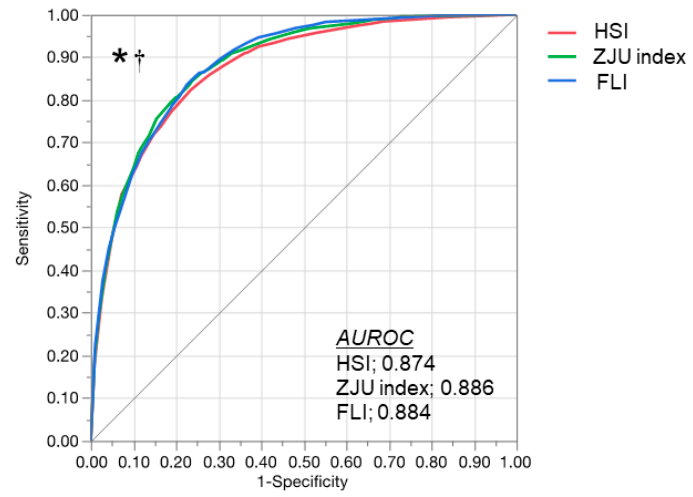
Figure 2. ROC curve of the HSI, ZJU index, and FLI for detecting NAFLD. ROC curve of the HSI (red), ZJU index (green) and FLI (blue) for the diagnosis of NAFLD in overall subjects. The ZJU index and FLI showed a greater area under the ROC curve than the HSI. * p < 0.05 in the comparison between the ZJU index and HSI. † p < 0.05 in the comparison between the FLI and HSI by the DeLong test. AUROC, area under the receiver operating characteristic; FLI, fatty liver index; HSI, hepatic steatosis index; NAFLD, nonalcoholic fatty liver disease; ROC, receiver operating characteristic; ZJU, Zhejiang University.